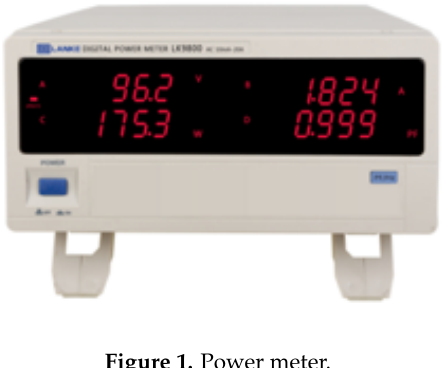
Figure 1. Power meter.